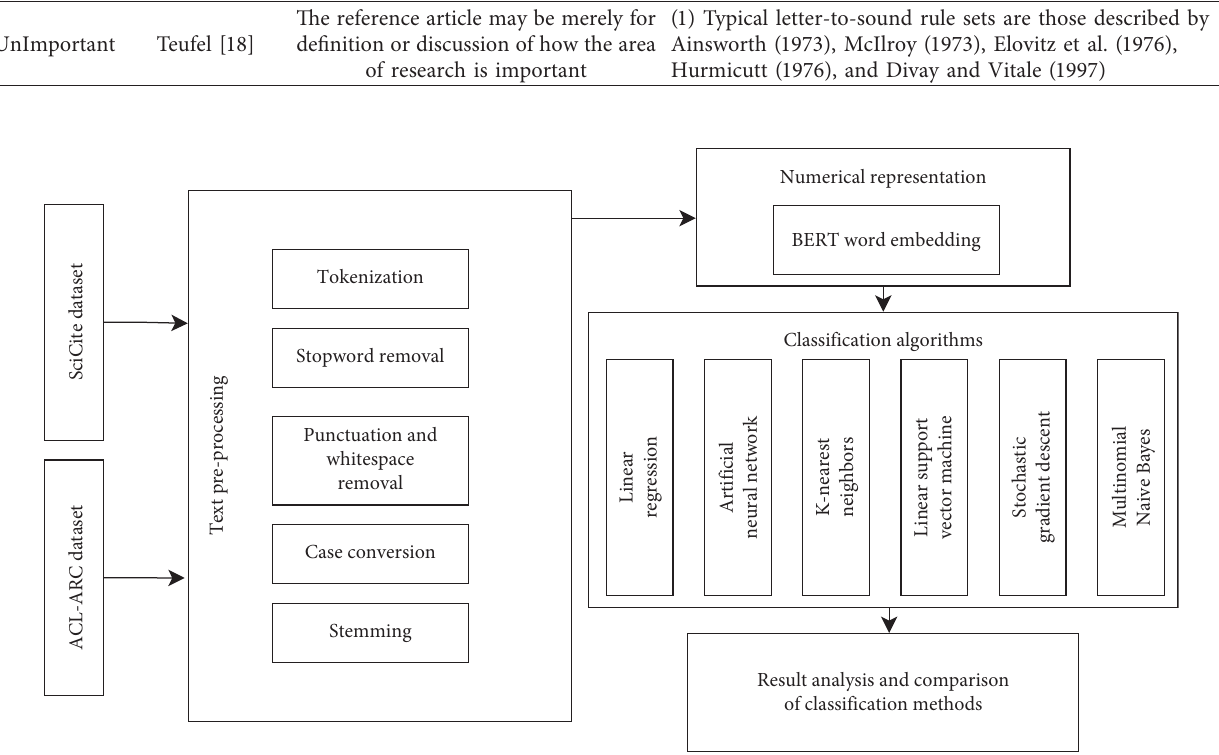
Figure 2: Framework of the proposed study for the citation content classification study. Table 2: Distribution of records in citation intent classes in selected datasets. SrNo.